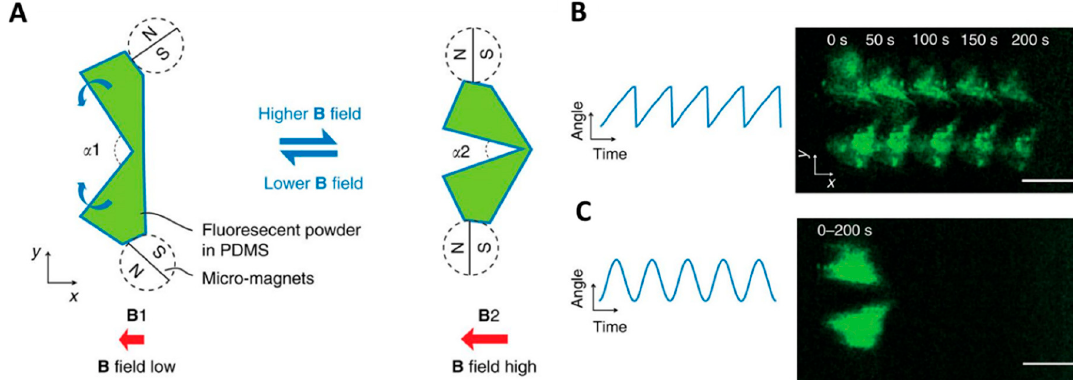
Figure 8. ( A ) Schematic drawing of a micro-scallop from the top view. The green shapes illustrate the opening and closing shape change of the micro-scallop when actuated by an external magnetic field. ( B ) Forward net displacement of the micro-scallop in a shear thickening fluid and asymmetric actuation (blue curve). ( C ) Forward net displacement of the micro-scallop in a shear thickening fluid with symmetric actuation (blue curve). Adapted with permission from Reference [108], copyright Nature Communications 2014.